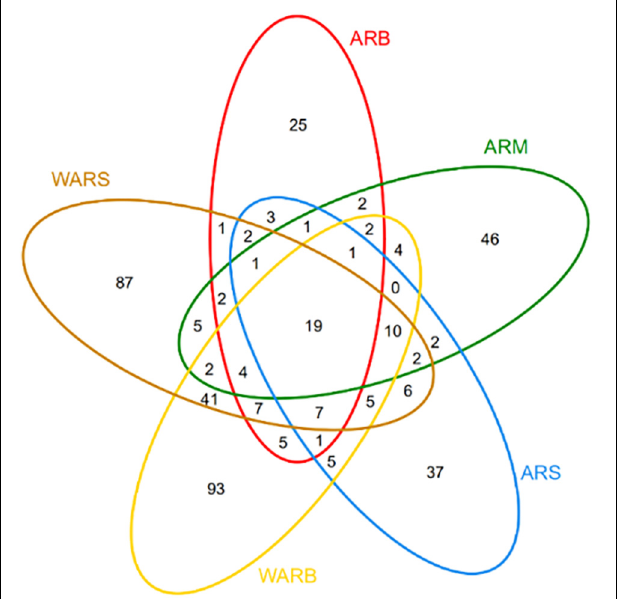
FIGURE 2 | Venn diagram. The number in each region indicates the number of shared or unique OTUs for the group contained in the region.